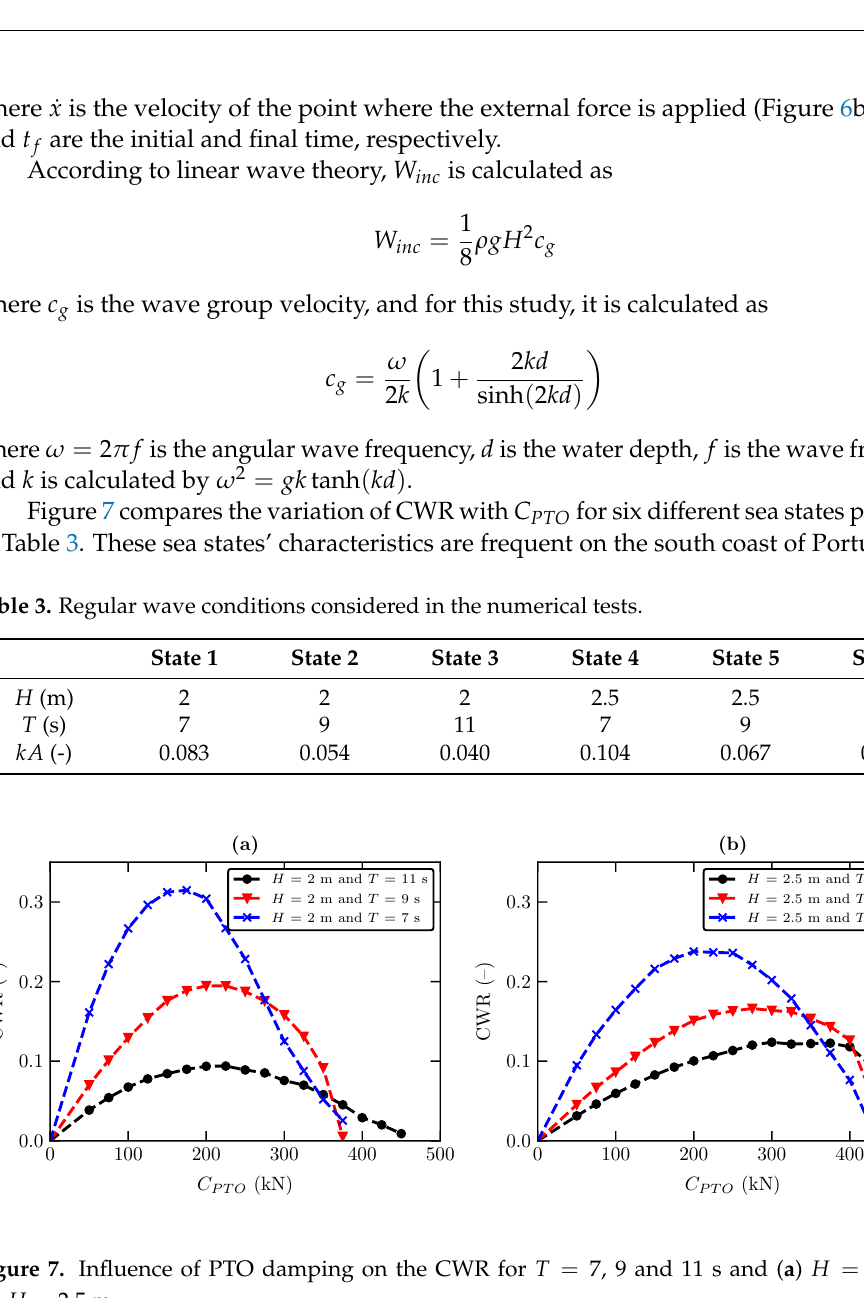
Figure 7. Influence of PTO damping on the CWR for T = 7, 9 and 11 s and ( a ) H = 2 m and ( b ) H = 2.5